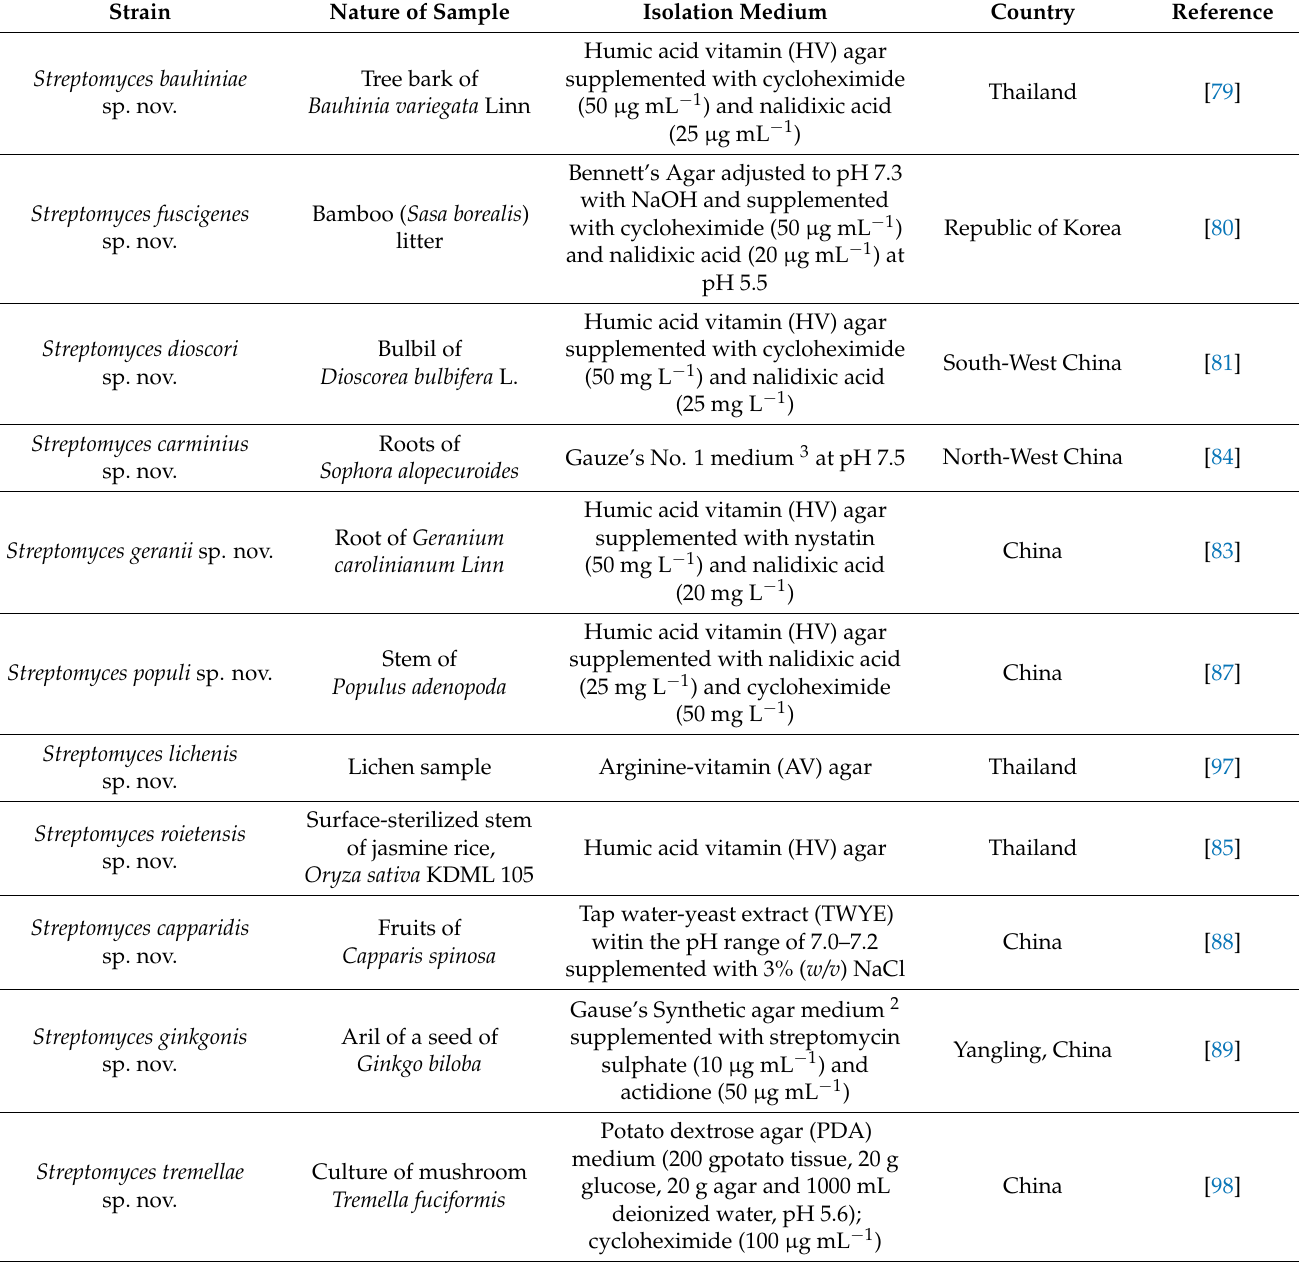
Table 2. Novel Streptomyces spp. reported from plants and Fungi between 2015 and